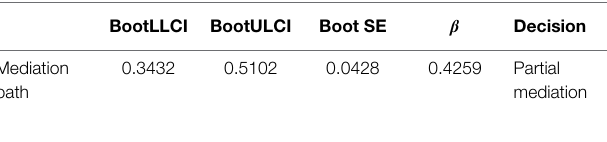
TABLE 6 | Mediation